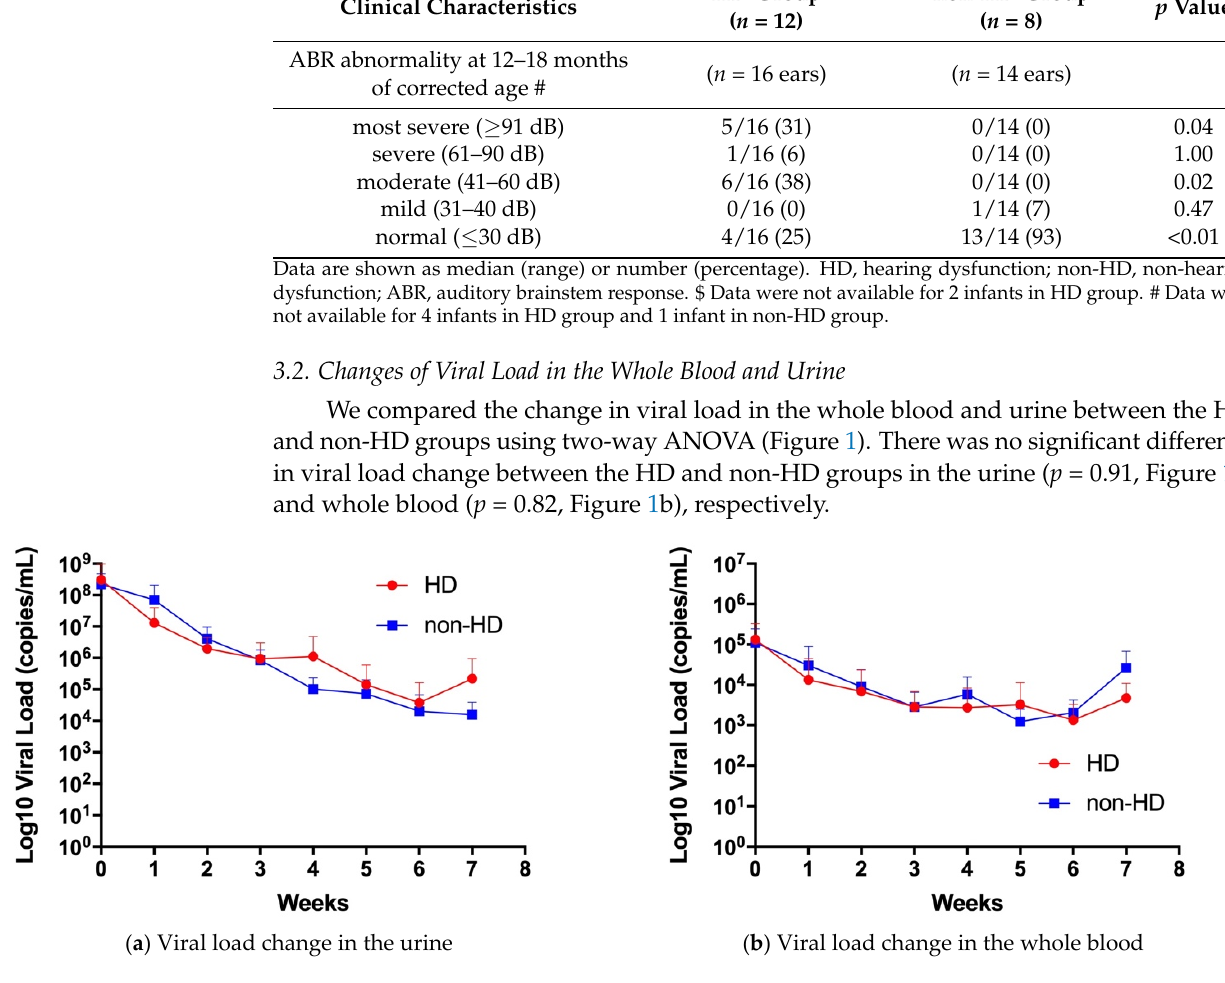
Figure 1. CMV viral load change in the urine and whole blood. ( a ) Viral load change in the urine, n = 12 in HD group (1 missing data in week 7), and n = 8 in non-HD group (2 missing data in week 7). ( b ) Viral load change in the whole blood, n = 12 in HD group (1 missing data in week 7), and n = 8 in non-HD group (1 missing data in week 1 and 3 missing data in week 7). Red circle symbols represent HD group and Blue square symbols represents non-HD groups. Data are shown as mean ± standard deviation. HD; hearing dysfunction, non-HD; non-hearing dysfunction.